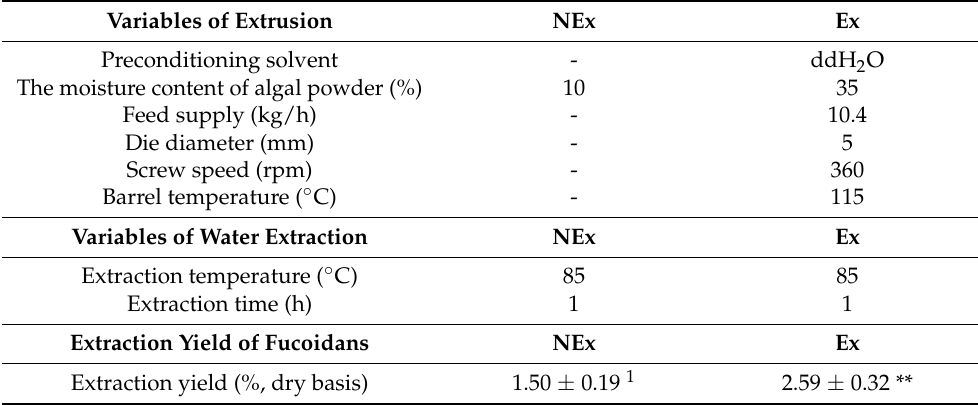
Table 2. Extrusion variables, extraction variables, and extraction yields of crude extracts of fucoidan for NEx and Ex. Variables of Extrusion NEx Ex Preconditioning solvent - ddH 2 O The moisture content of algal powder (%) 10 35 Feed supply (kg/h) - 10.4 Die diameter (mm) - 5 Screw speed (rpm) - 360 - 115